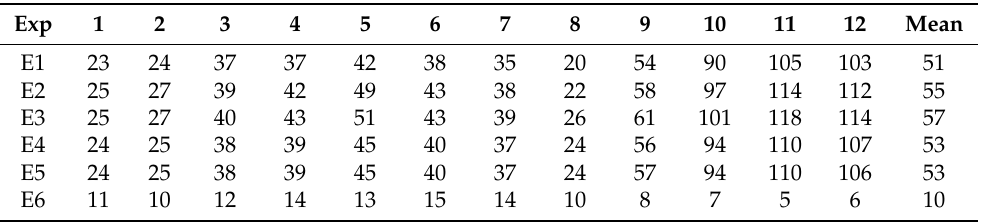
Figure 3. Spatial distributions of the calculated drag coefficients in ( a – f ) at 08:00 am on 31 August 1970 during Typhoon 7008. Table 4. Root mean square errors between the simulated storm surge levels and observations in every period of Typhoon 7008 (unit: